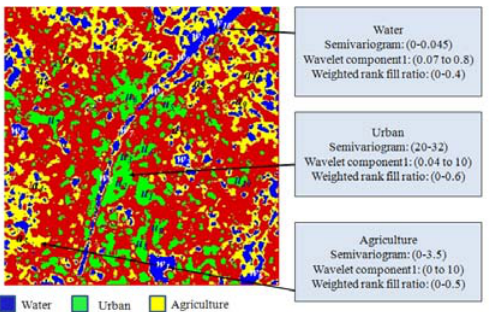
Figure 3. Clustered SAR image- texture measures for each